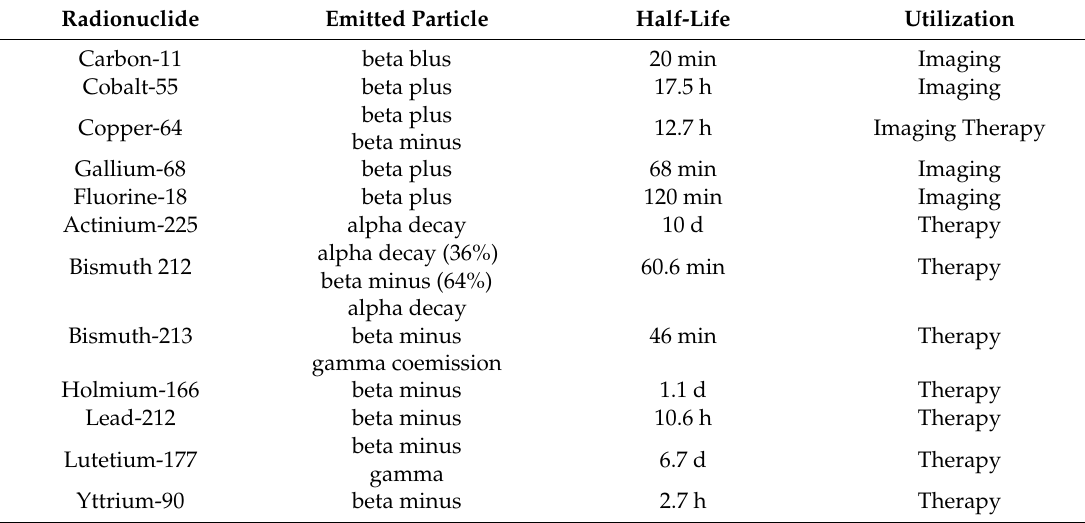
Table 1. Diagnostic and therapeutic